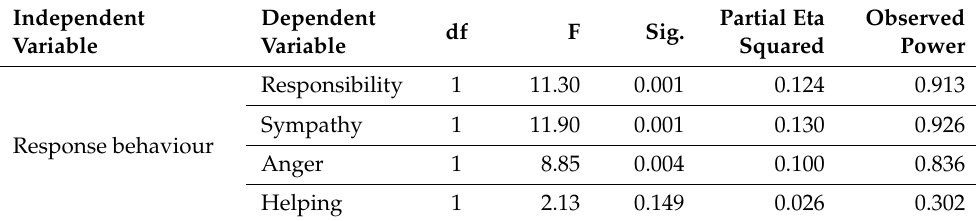
Table 2. Effects of Target Coping Behaviour and Perpetrator Response Behaviour on Perceptions of the